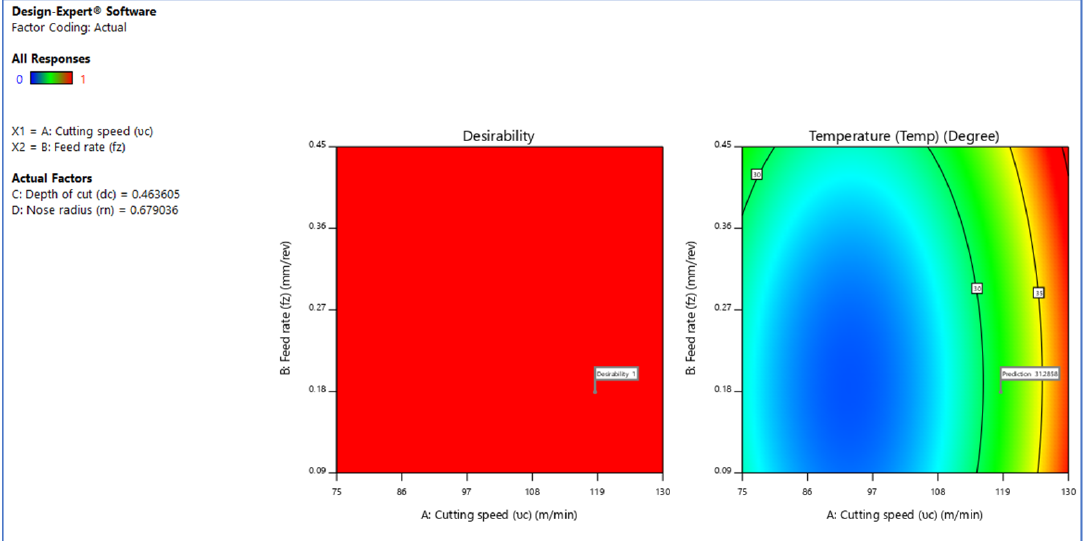
Figure 12. Contour plot of the variable on temperature.